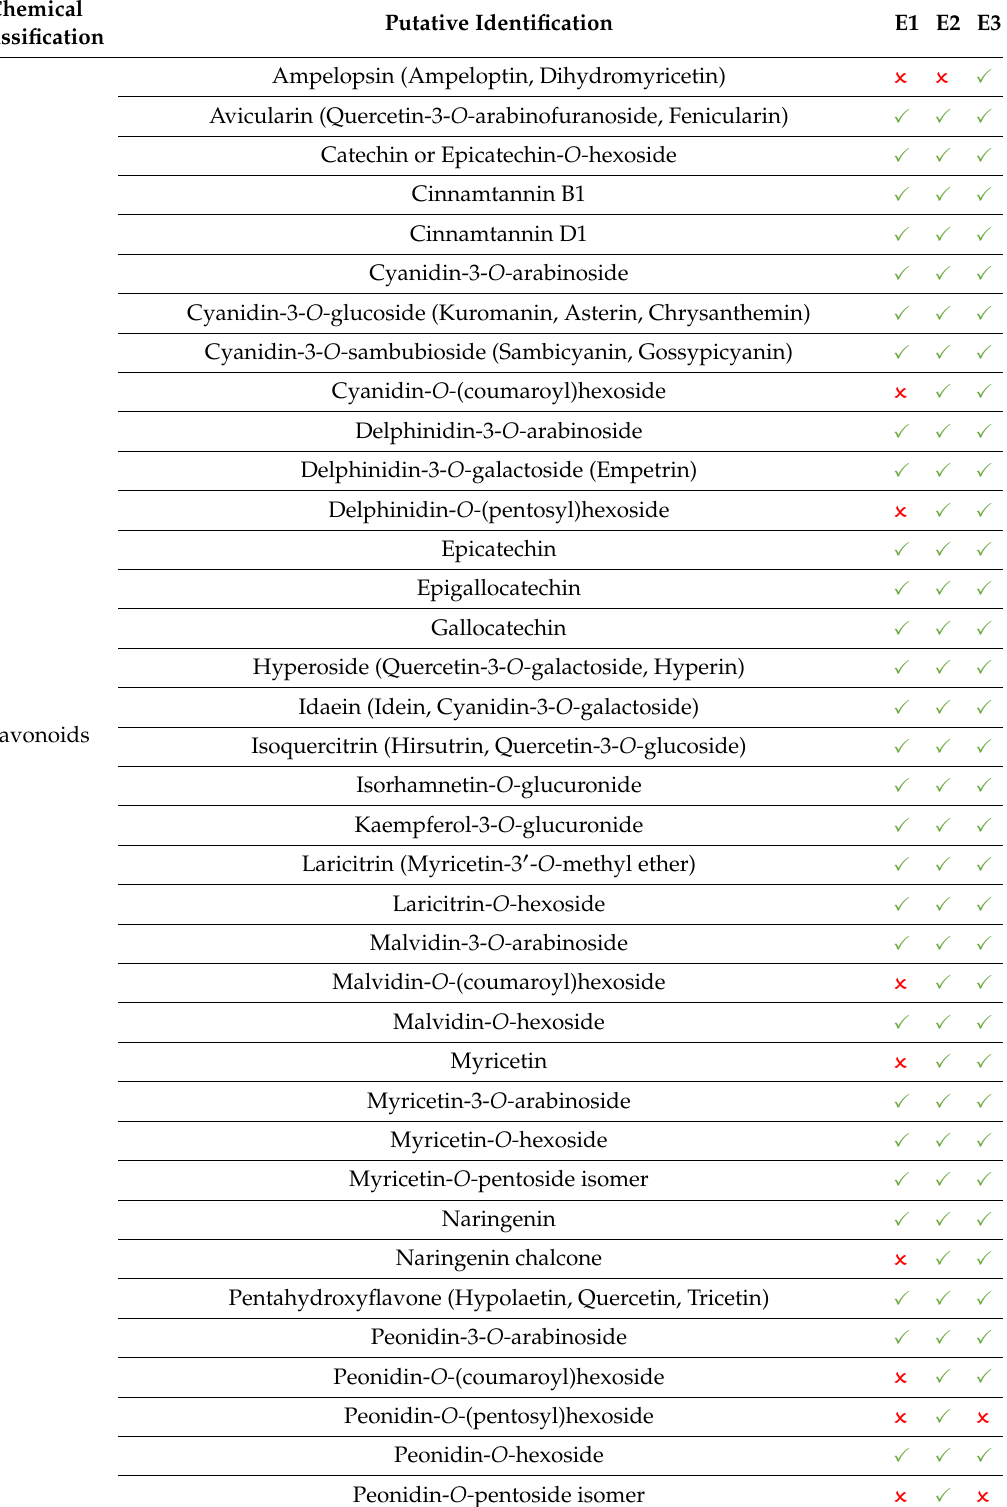
Table 1. Summary of the putative identification of phytonutrients in the extracts, with compounds pertaining to each extract (E1, E2, and E3) marked —if present and —if absent. Compounds are organized by chemical classification.